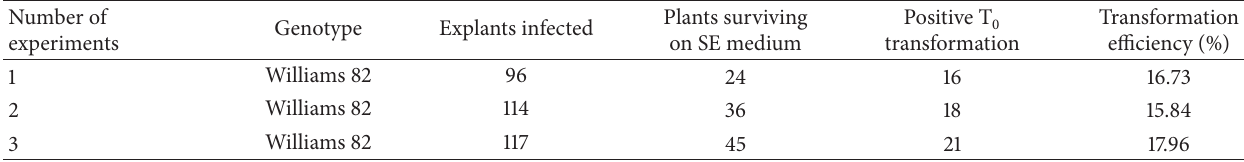
Table 2: Transformation efficiency of soybean cotyledonary-node explants inoculated with Agrobacterium tumefaciens ’s strain EHA101